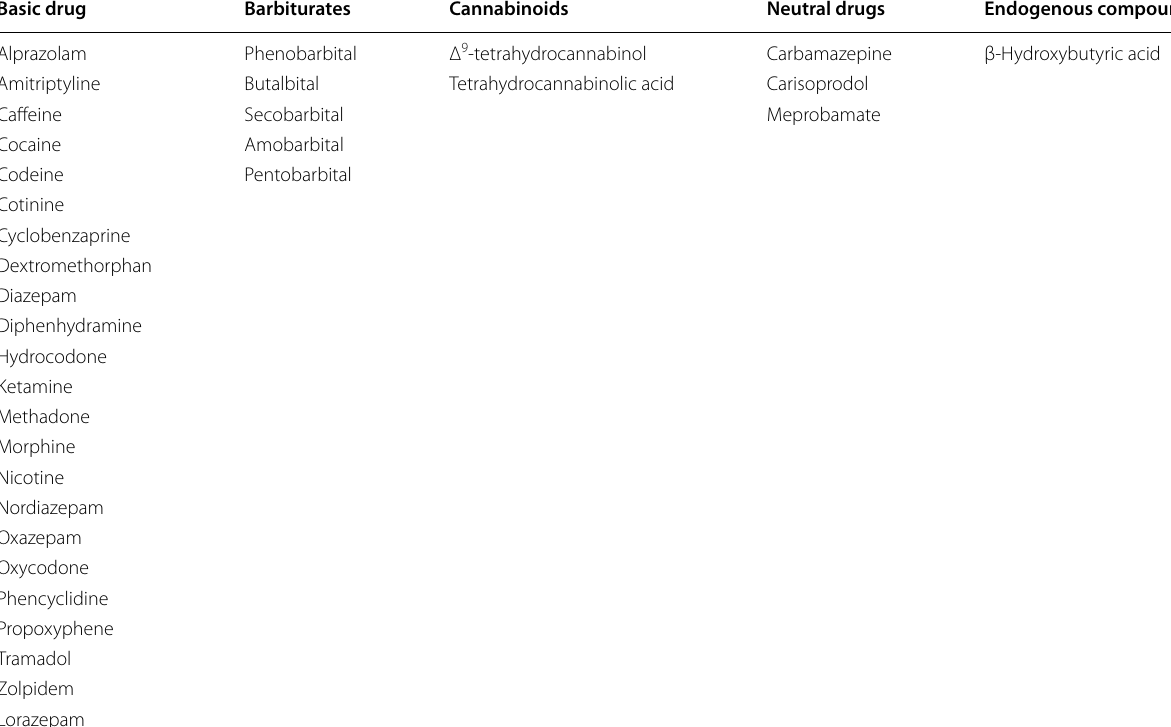
Table 2 A34 Common drugs of abuse used in drug interference study Basic